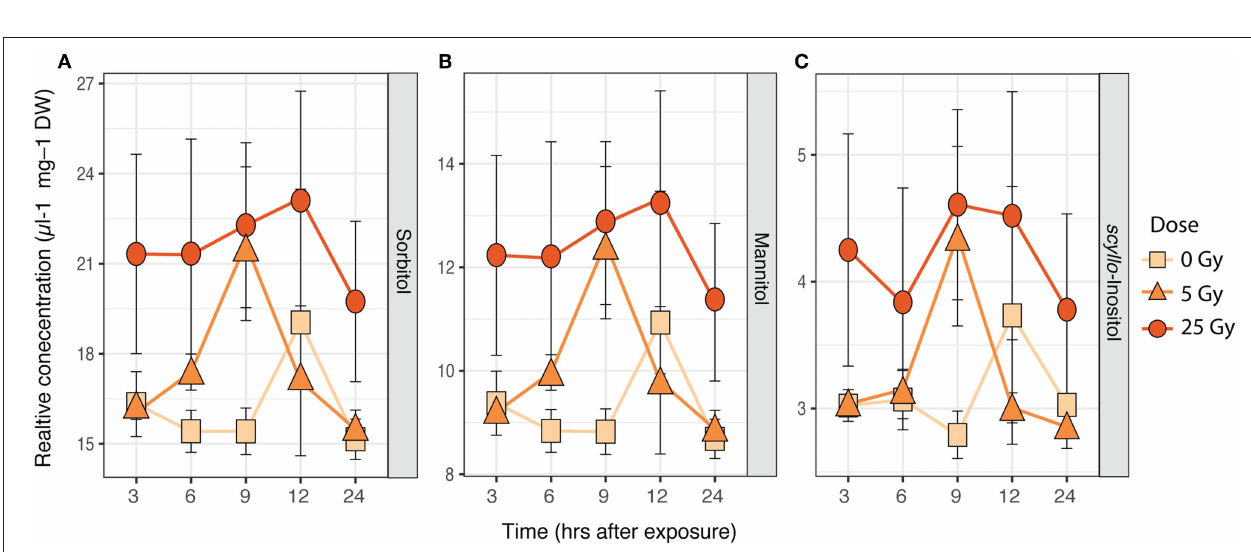
FIGURE 4 | Time series of average relative concentrations ( ± SE, n = 3) of metabolites identified by the SIMPER analysis as contributing 80% to the cumulative dissimilarity between doses ( Table S2 ) in E. magnus . (A) Sorbitol, (B) mannitol, and (C) inositol (scyllo).